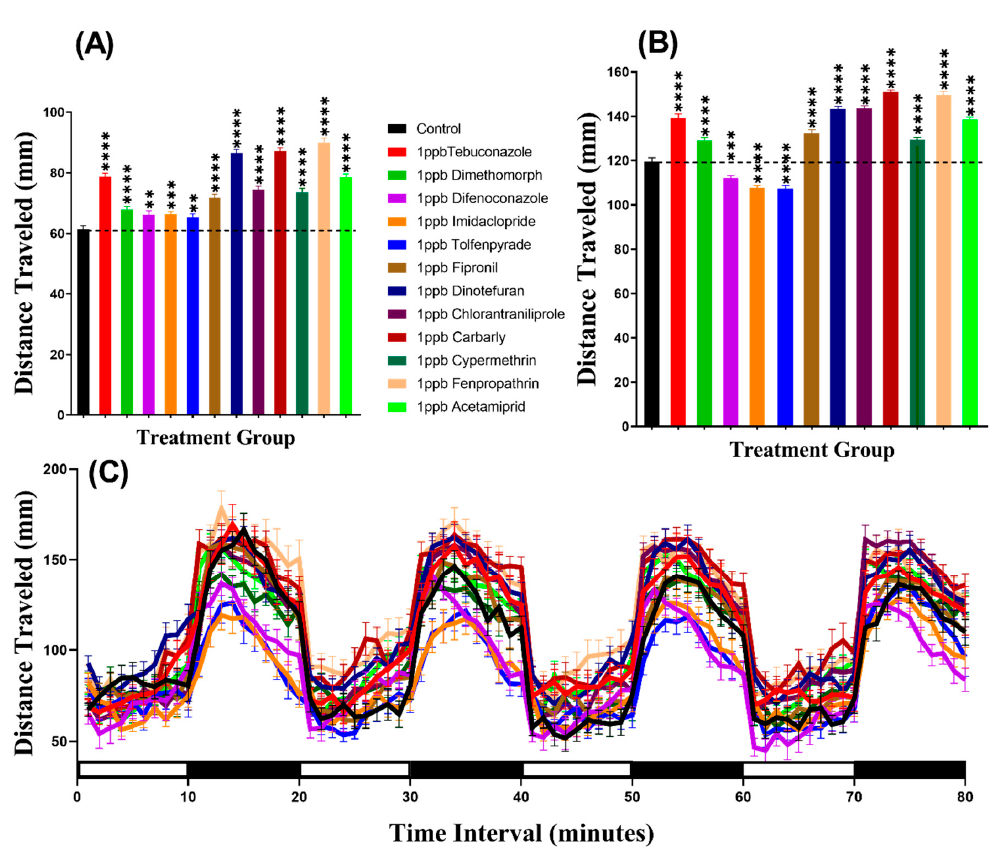
Figure 2. Average distances of zebrafish larvae traveled in the control and 24-h 1 ppb pesticide treatments. ( A ) Total traveled distance during the light cycle. ( B ) Total traveled distance during the dark cycle. ( C ) The pattern of locomotor activity during light / dark transitions. The data were expressed as the Mean ± SEM and analyzed by Two-way ANOVA and Brown–Forthsythe and Welch ANOVA test. Dunnett’s multiple comparison test was carried out for comparing all treatments with control to obtain the pesticide effects ( n = 24; ** p < 0.01, *** p < 0.001, **** p < 0.0001).